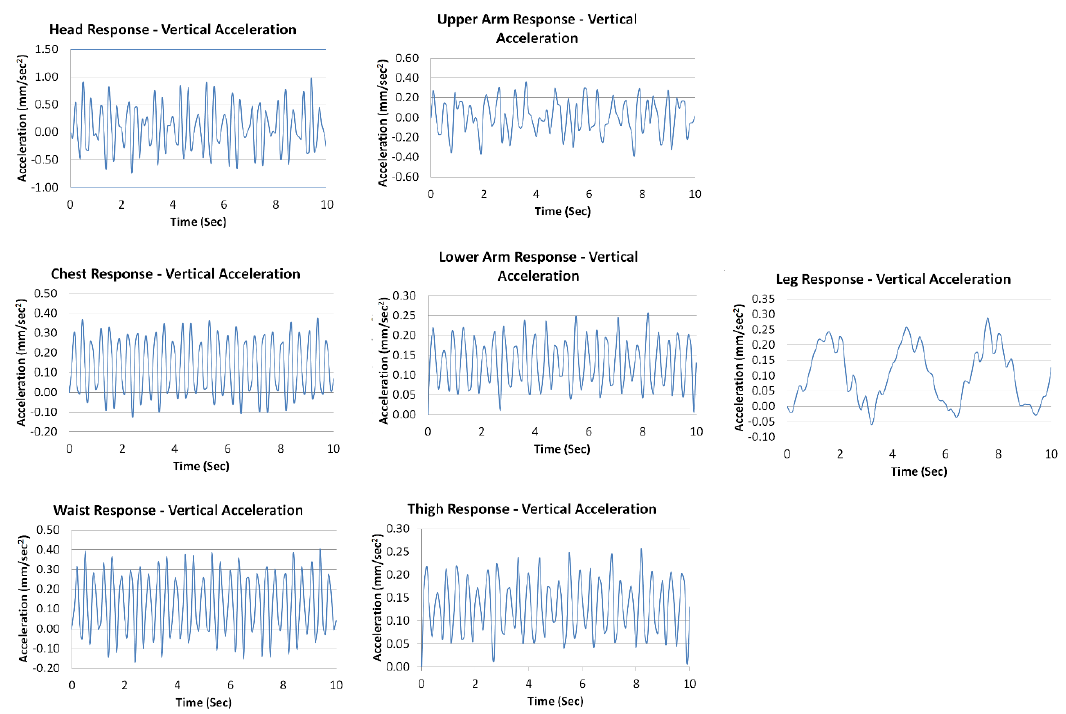
Figure 5. Vertical accelerations of the points of interest.